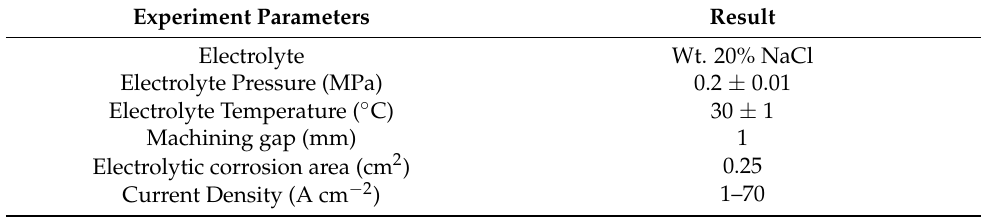
Table 3. Current efficiency measurement experiment parameters.